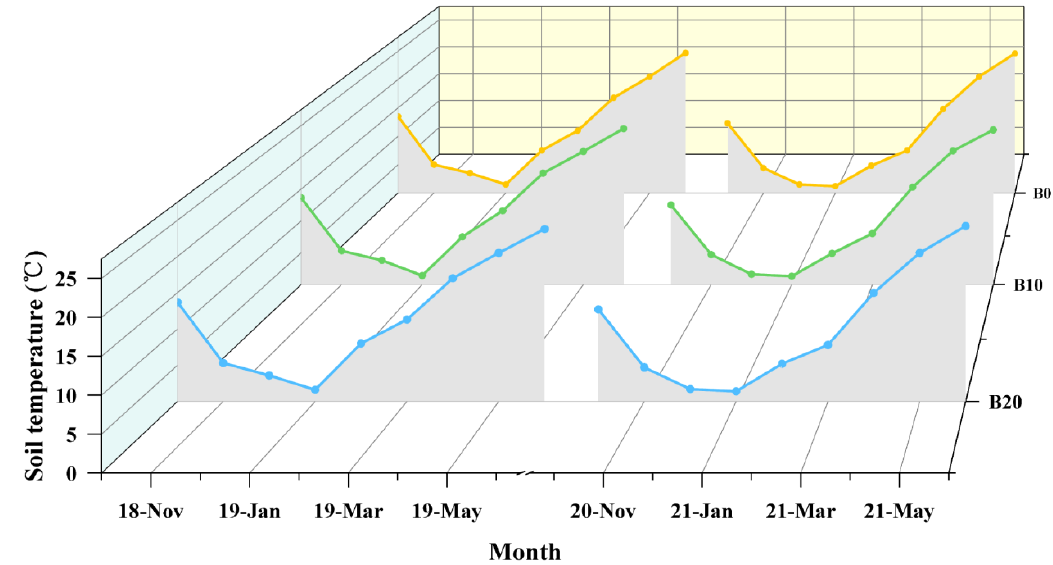
Figure 4. Changes in soil temperature at a depth of 10 cm under different amounts of added bio-